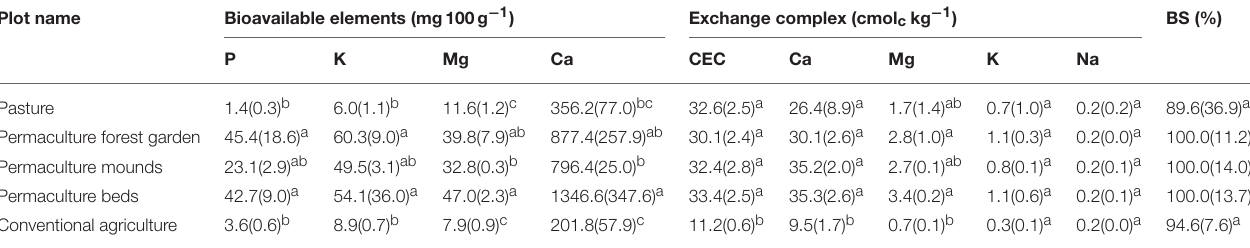
TABLE 6 | Soil bioavailable and exchangeable